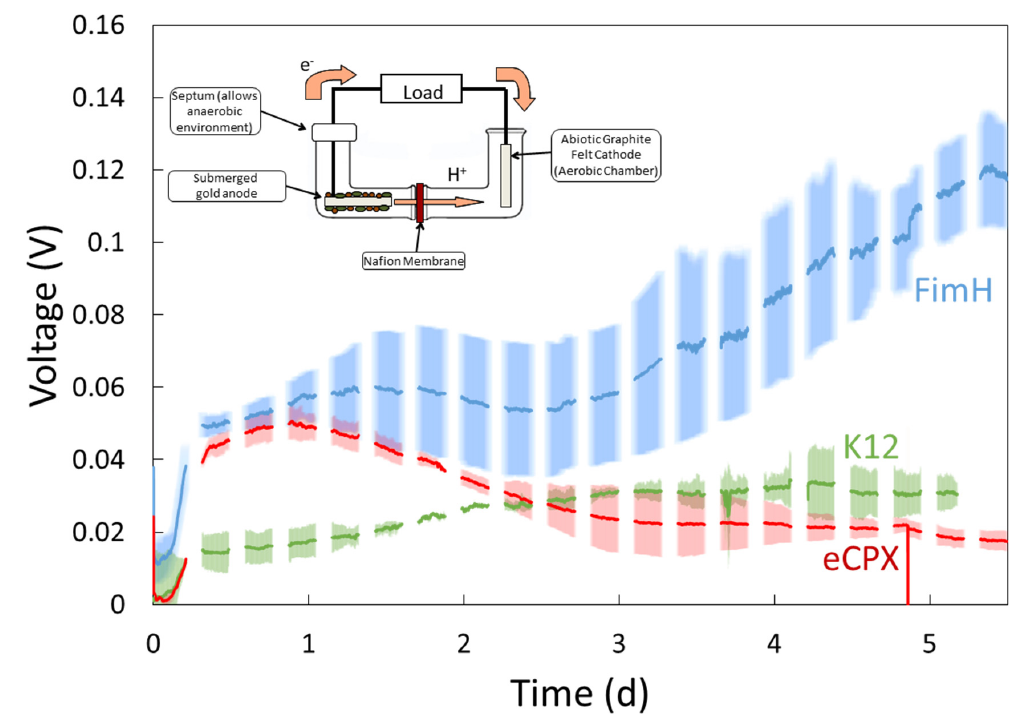
Figure 4. Voltage in U-tube microbial fuel cells (schematically shown inset) held at 1 M Ω and inoculated with cells displaying either the p8#9 peptide on other the eCPX or FimH scaffold, or lacking either scaffold altogether (labeled K12). The shaded regions show one standard error away from the average calculated from multiple runs (n = 3 FimH, n = 2 K12, eCPX). Cells displaying eCPX and FimH outperform the K12 cells within the first day and the FimH scaffold cells continue to produce higher voltages throughout the experiment.